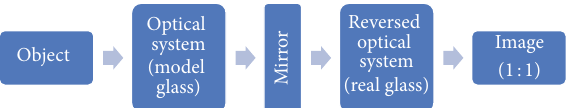
Figure 1: Forward and reversed ray tracing